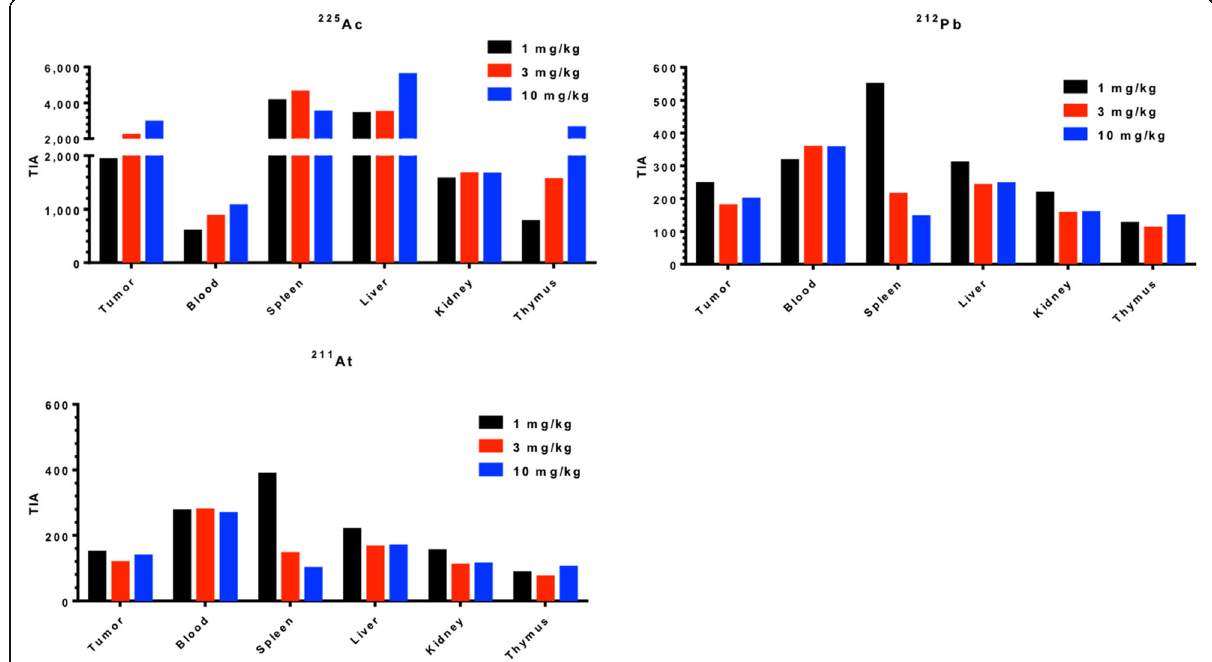
Fig. 11 Time-integrated activity (TIA) of the tumor, blood, spleen, liver, kidney, and thymus for the radionuclides a 225 Ac, b 212 Pb, and c 211 At- anti-PD-L1-BC labeled with the protein concentrations 1 mg/kg ( black bar ), 3 mg/kg ( red bar ), and 10 mg/kg ( blue bar